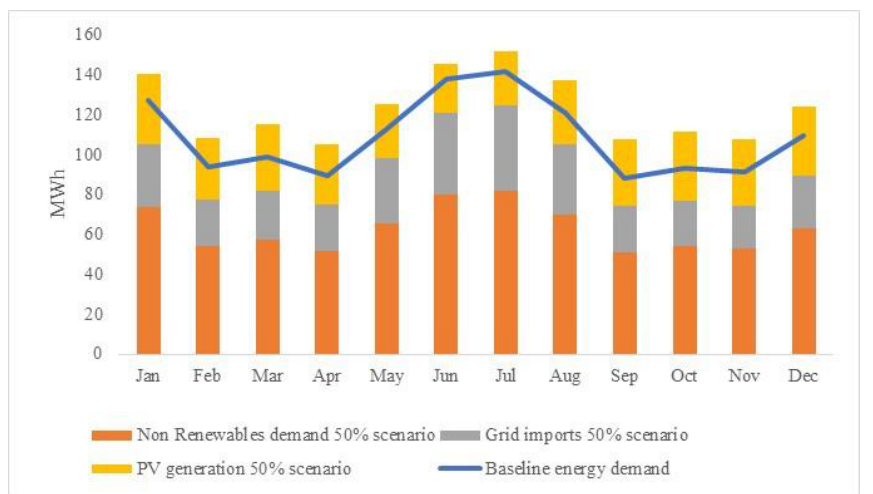
Figure 12. Area maximum demand by scenario per half hour period.